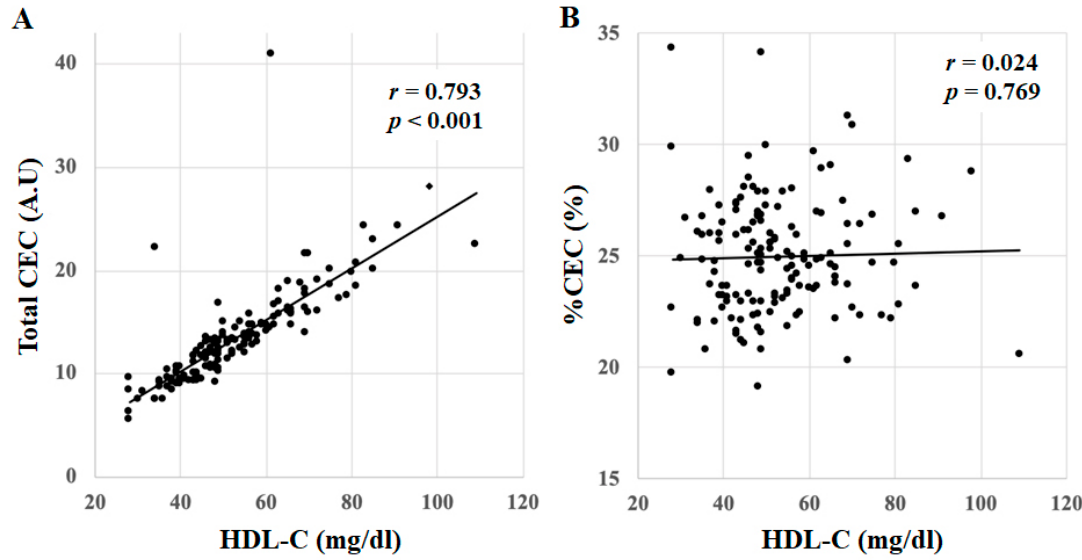
Figure 3. Correlations between ( A ) %CEC, ( B ) total CEC and HDL-C in all patients. A.U : arbitrary unit.